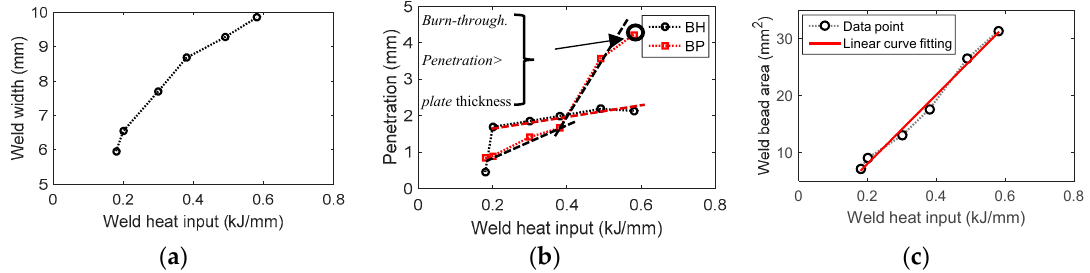
Figure 6. The relationship between weld heat input and ( a ) weld width, ( b ) penetration and ( c ) area of weld bead (BH: Bead Height, BP: Bead Penetration).